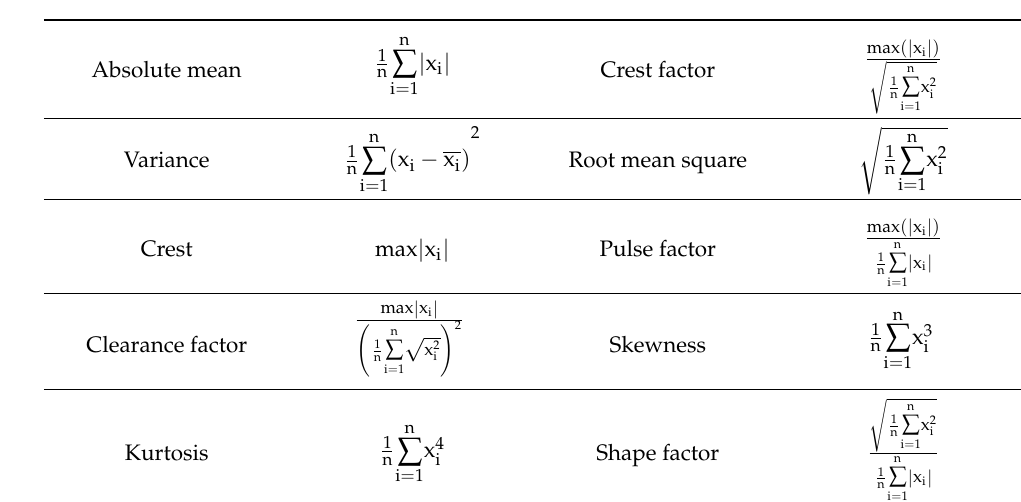
Figure 8. Identification accuracies on three datasets by seven methods. Table 3. Features selected in the time domain.